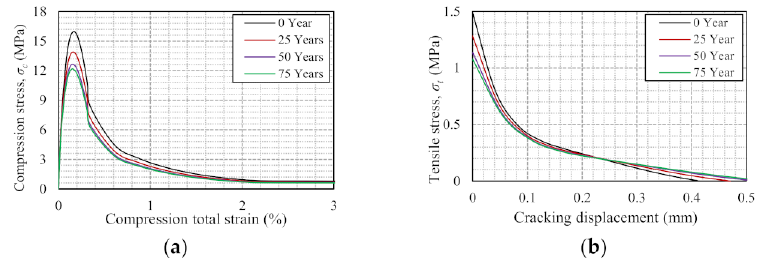
Figure 8. ( a ) Behavior of concrete compression stress–strain hardening; ( b ) concrete softening behavior considering crack opening displacement.